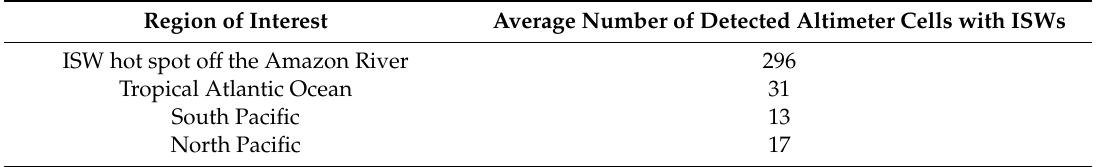
Table 1. Number of detected ISW-like events with the algorithm described in this paper. Region of